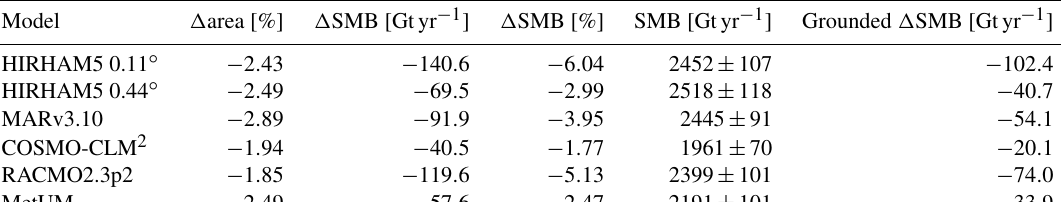
Table 1. From left to right the columns show the RCM name; (cid:49) area % and (cid:49) SMB – both between the common mask and the native Gtyr -1 mask over the ToAIS; (cid:49) SMB % – the difference between (cid:49) SMB and the SMB ensemble mean from Mottram et al. (2021), which is Gtyr -1 2329Gtyr − 1 , the yearly SMB for the individual models integrated over the common mask with uncertainties of 1 standard deviation; and finally (cid:49) SMB over the grounded AIS. Gtyr -1